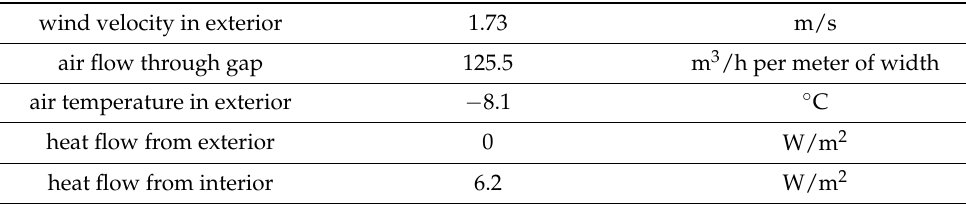
Table 2. Boundary conditions of summer extreme in January